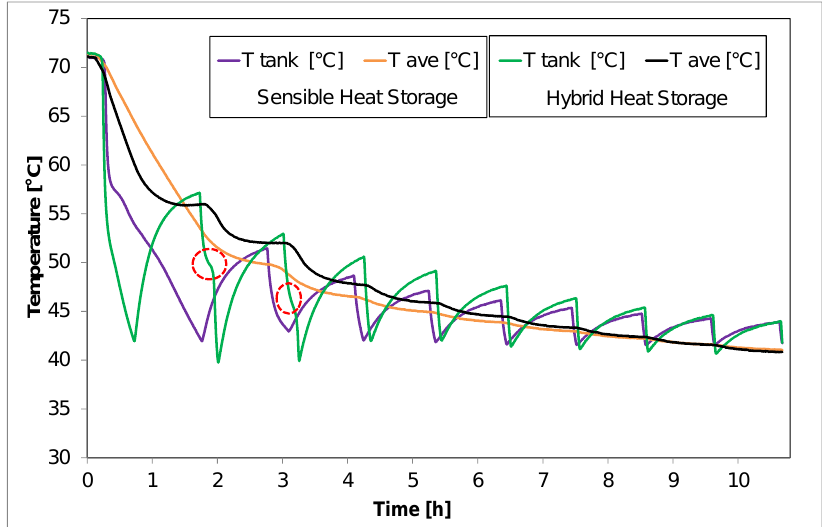
Figure 7. Dynamic evolution of the temperatures inside the TES system in sensible and hybrid configurations under Test B conditions. Highlighted in red: the phase transition effect in the hybrid TES system.